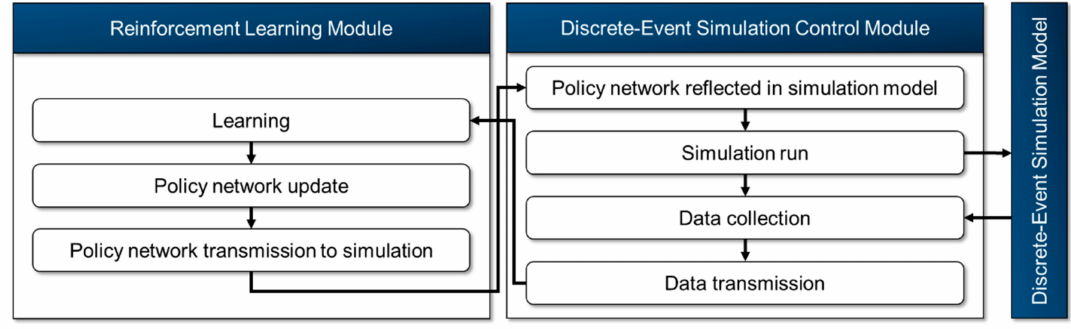
Figure 3. Manufacturing simulation and DRL-integrated software architecture.